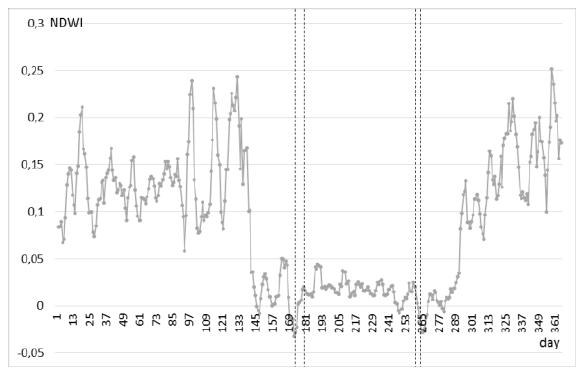
Figure 3. Annual NDWI graph of 2018 for the Irael meteorological station; values are averaged using 5-day sliding window; time frames of growing seasons are marked by dashed vertical lines